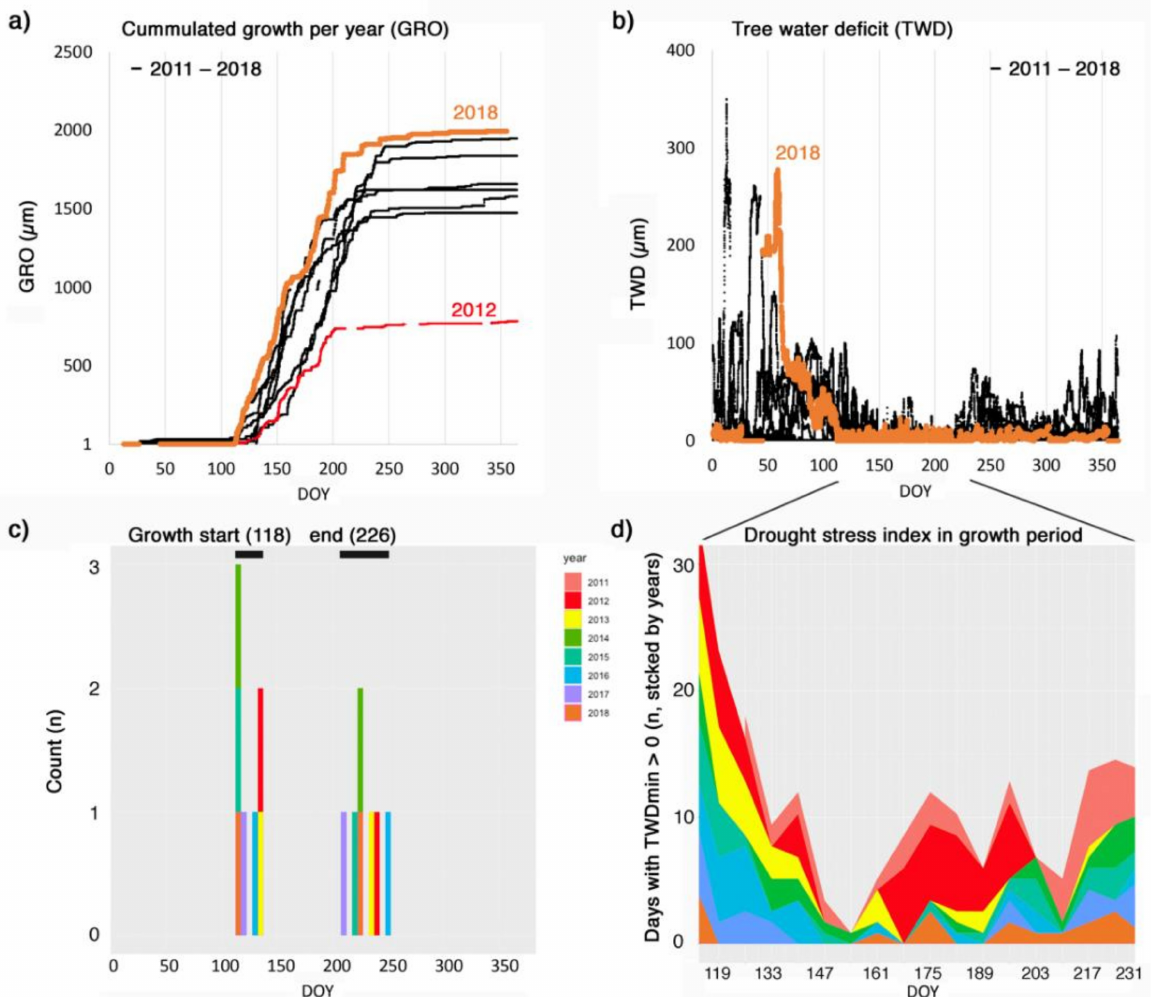
Figure 5. Example of stem radius data of a beech tree over eight years at a 10 min time resolution (TreeNet Lausanne, Switzerland). ( a ) Accumulated growth per year (GRO). The year with the summer drought (2018) and the year with the lowest growth (2012) are coloured. ( b ) Tree water deficit (TWD). ( c ) Timing of growth start and growth end (median in brackets). Years are colour coded. ( d ) Drought stress index derived from TWD for the growth period. The index counts days with a minimum TWD > 0 per week, i.e., days where the loss of water was larger than the uptake. Note, these diagrams are not direct outputs of treenetproc and are solely intended as a possible representation of results relevant for